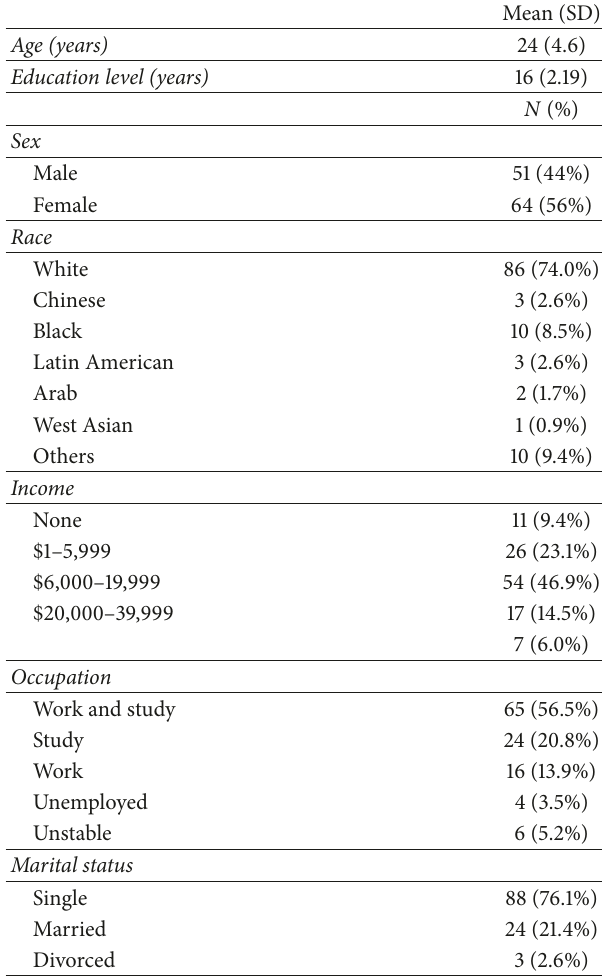
Table 1: Demographic characteristics of